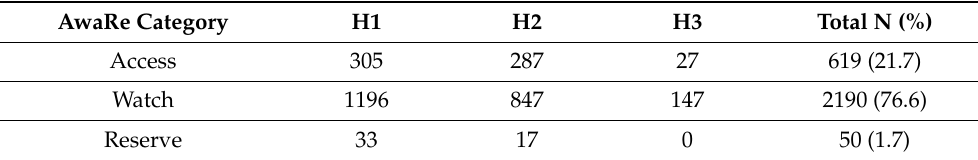
Table 7. Detail of prescribed antibiotics according two WHO AwaRe